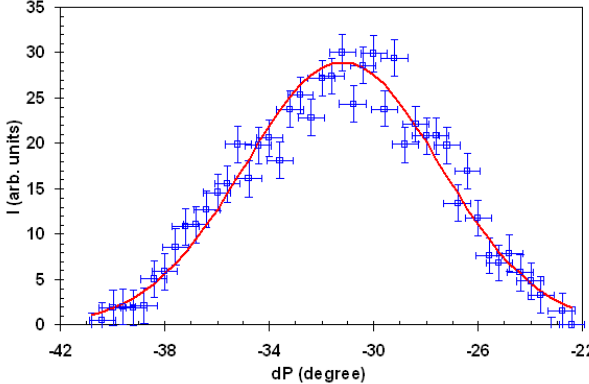
FIG. 11. (Color) Beam bunch shape measured at the second SCL cavity with the BCM in a phase scan, beam phase width (sigma) is approximately 3.8 (cid:3) .